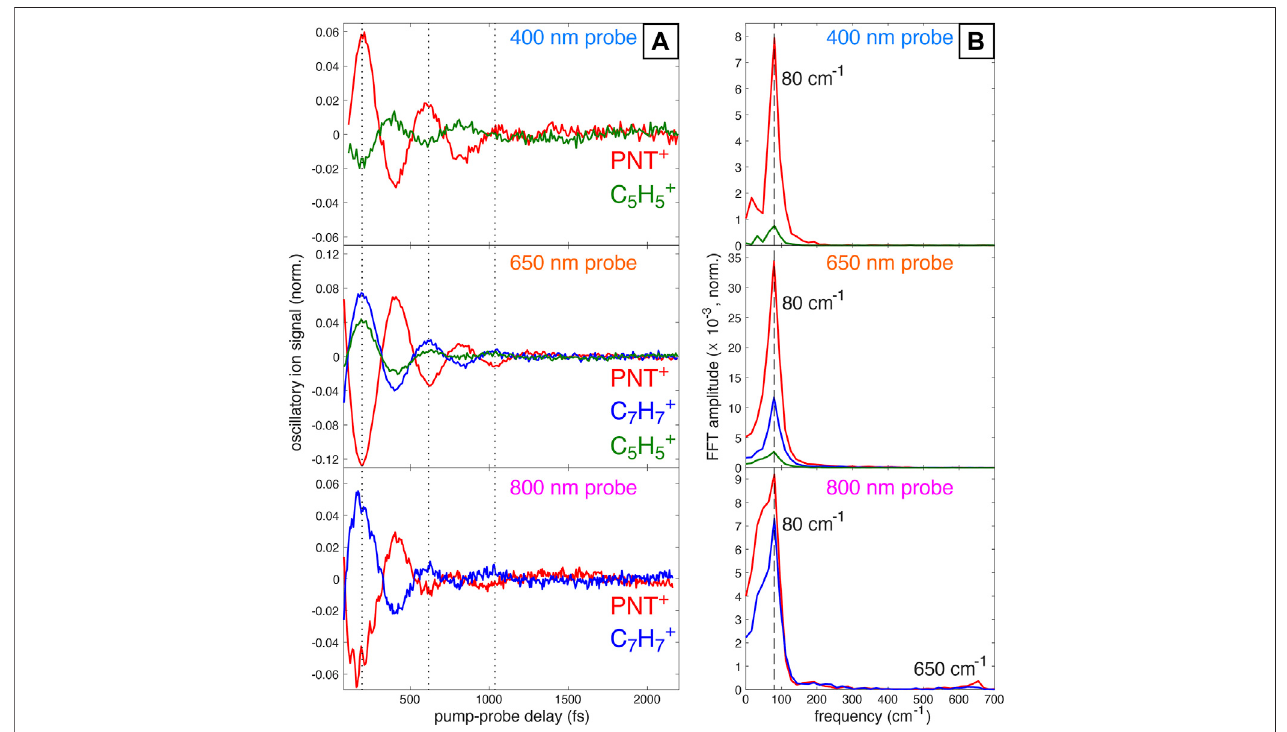
FIGURE2|(A) OscillatoryionsignalsforPNT + andselectedfragmentionsobtainedbysubtractingofftheincoherentcontributionstosignal fi tting via Eq.1 . (B) FFT amplitudes obtained from the signals in (A) with indicated frequencies at 80 cm − 1 and 650 cm − 1 (for 800 nm probe).